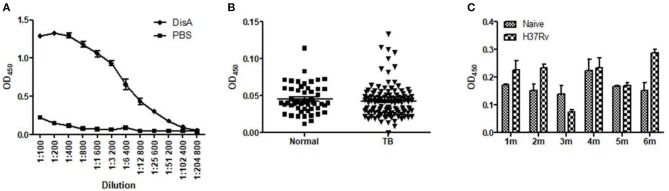
Specific anti-DisA antibodies in DisA immunized mice, TB patients, and Mtb-infected mice. (A) Sera were collected from purified protein DisA immunized BALB/c mice in our previous study and sera from PBS immunized mice as control, antibody titers against DisA were assayed by ELISA as shown dilution. (B) Antibody titers against DisA in TB patients (n = 53) and healthy control (n = 113) were assayed by ELISA (1:200). (C) Antibody titers against DisA in Mtb-infected mice. Sera were collected from BALB/c mice monthly at 1–6 month (m) post-infection, and specific anti-DisA antibody titers were detected by ELISA (1:200).